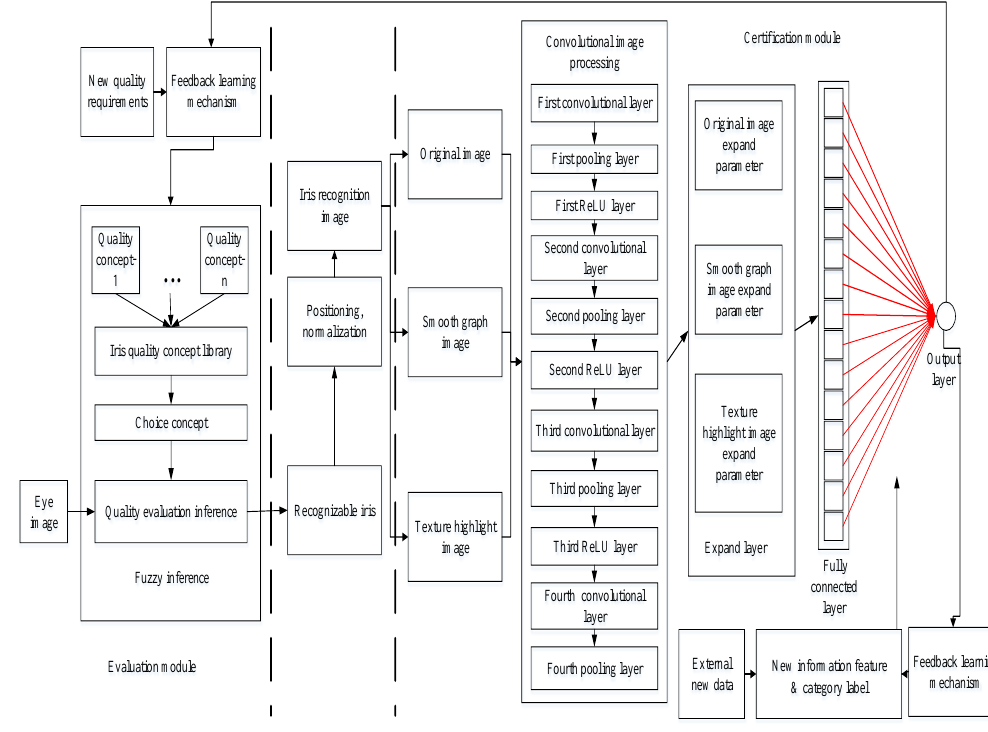
Figure 1. The overall working process of the method in this paper.